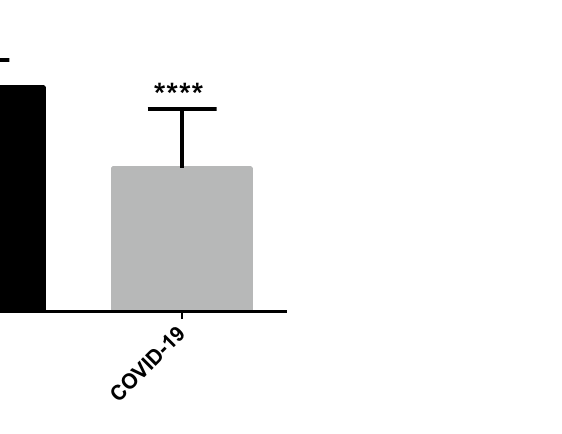
Figure 5. Total esterase activity concentrations in the saliva of COVID-19 patients (n = 66) and control group (n = 32). Asterisk indicates a significant difference between groups: ***p < 0.001. TEA: total esterase activity. Source: Prism 9.3, GraphPad software (https:// www. graph pad.